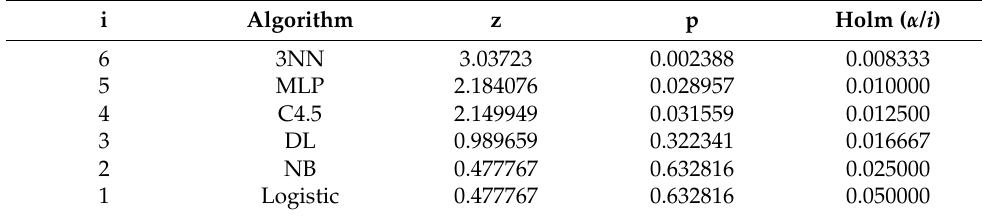
Table 9. Holm’s post hoc test for